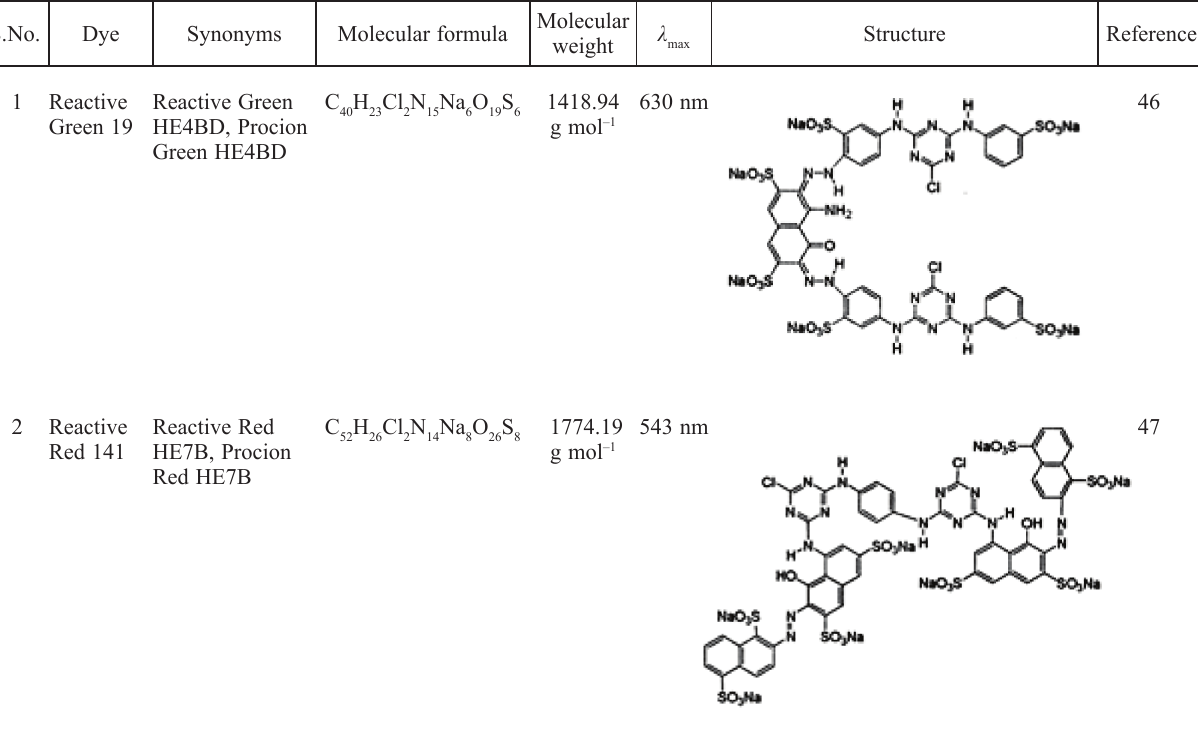
Table 1 – Details of dyes S.No. Dye Synonyms Molecular